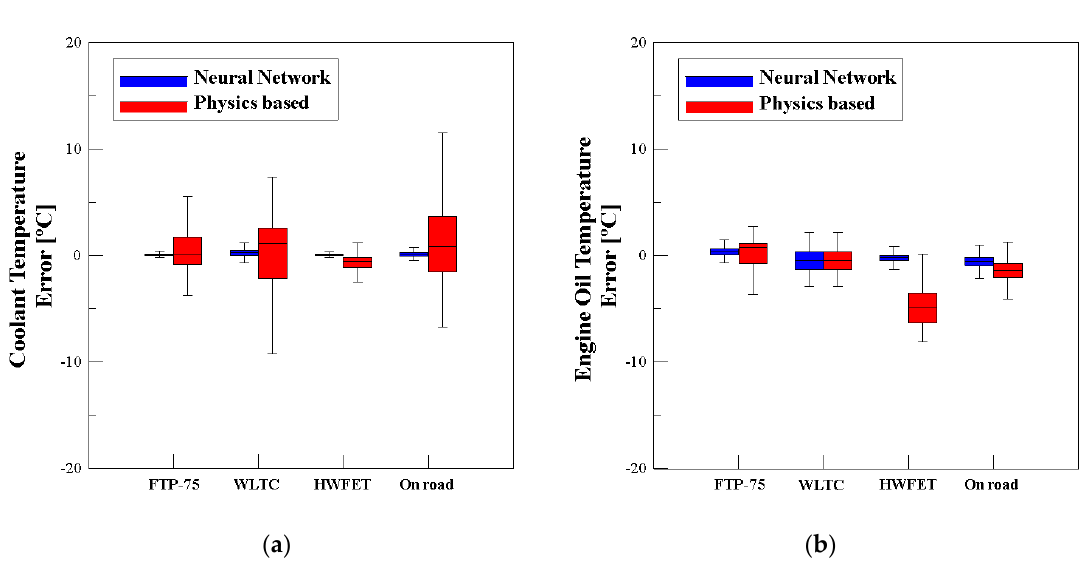
Figure 12. Prediction error expressed by the interquartile range method. The NN model and the physical-based model were compared under various driving conditions. ( a ) Coolant temperature; ( b ) Engine oil